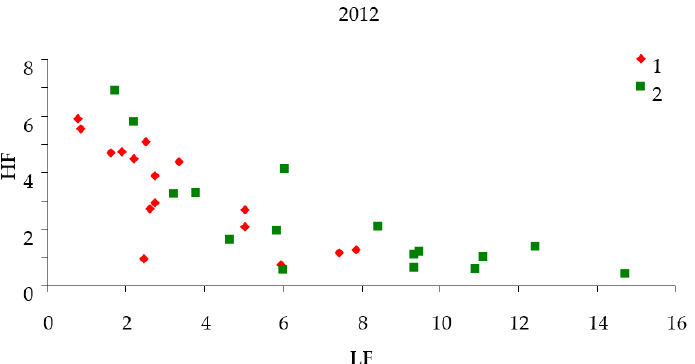
Figure 7. LF and HF parameters before outbreak of black fir sawyer (2012). 1—damaged areas; 2—control stands.